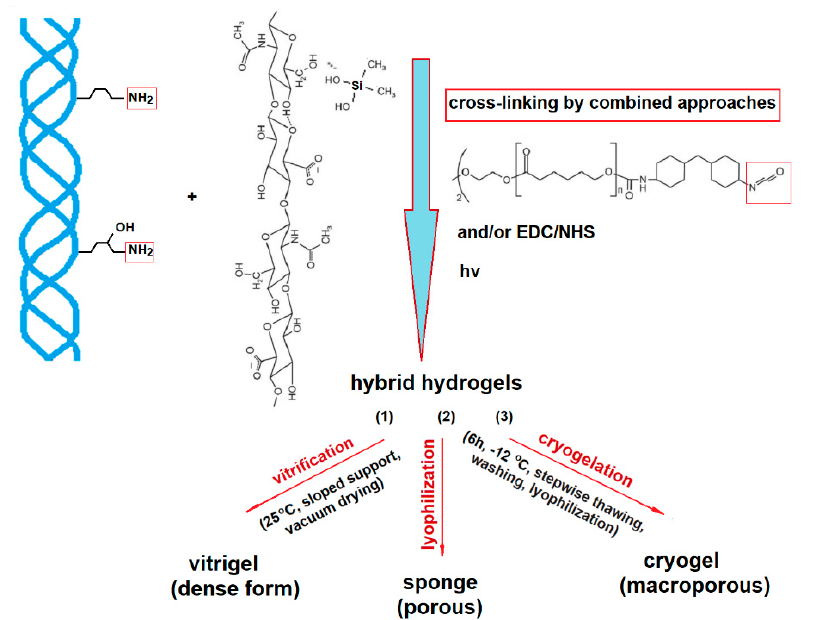
Scheme 1. Schematic representation of the preparative protocol for the investigated hybrid 3D